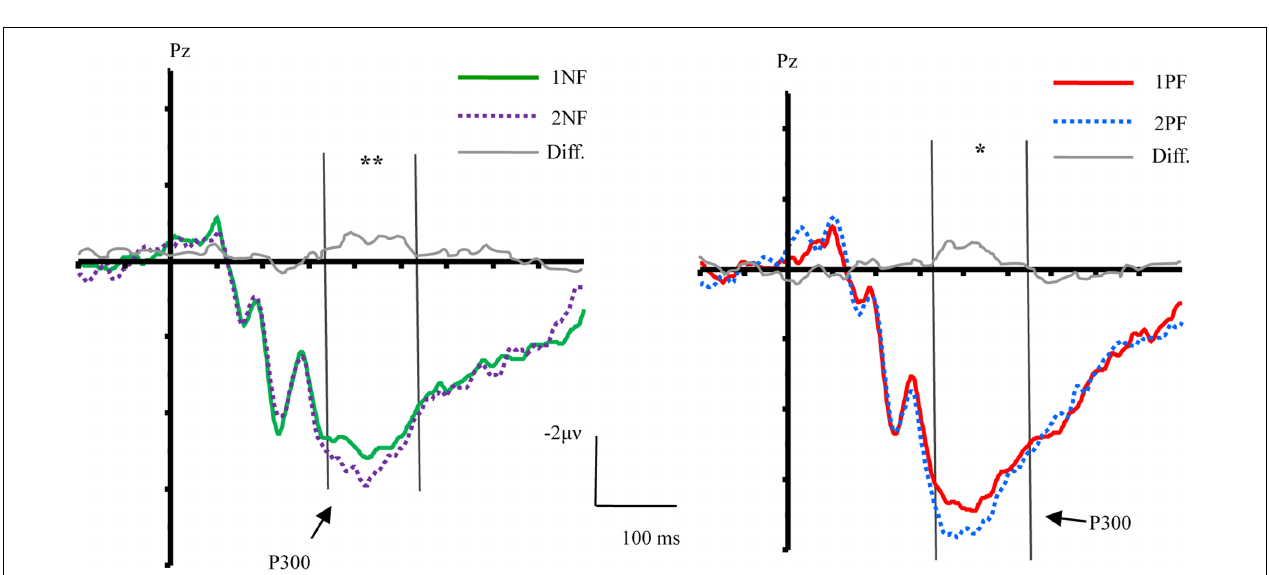
FIGURE 4 | The effect of order and topographical distribution on the difference at the Pz electrode. Left, ERPs evoked by negative feedback; Right, ERPs evoked by positive feedback. ∗∗ p < 0.01; ∗ p < 0.05.